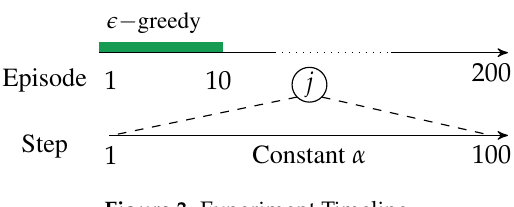
Figure 3. Experiment Timeline.